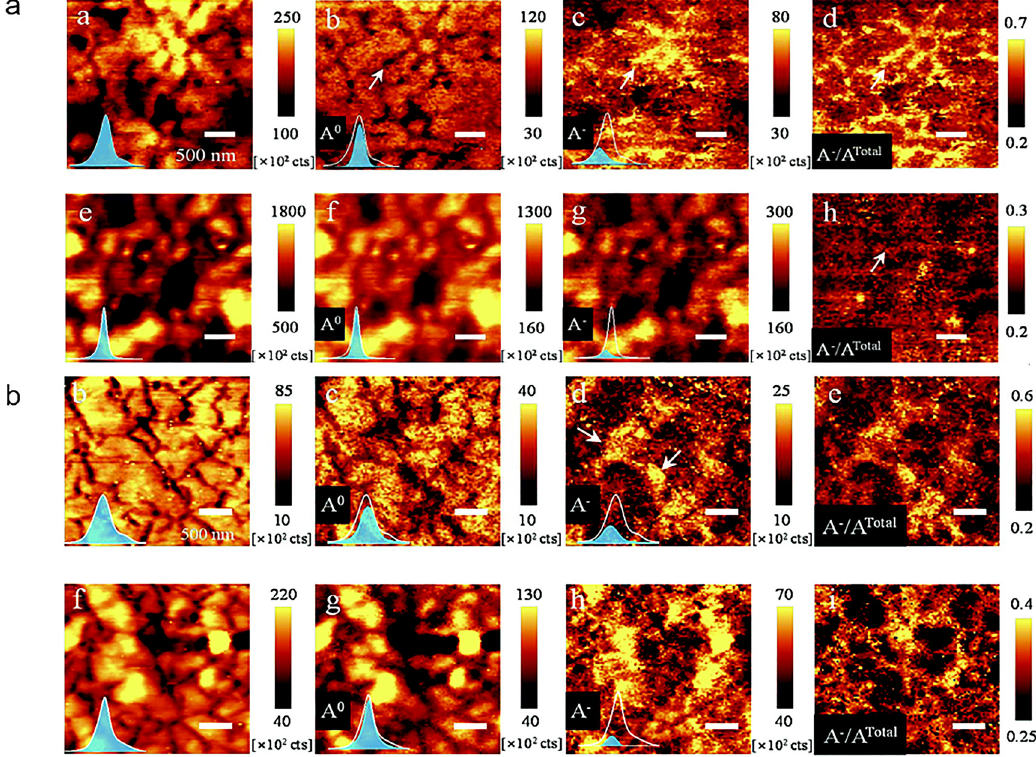
Figure 7: Near-field PL images of 1L-MoS2 by two different chemical treatment. (a) Near-field PL images of total, exciton, trion, and trion/total ratio 1L-MoS2 before (upper panel) and after TFSI-treatment (lower panel). (b) Near-field PL images of total, exciton, trion, and trion/total ratio of 1L-MoS2 before (upper panel) and after TCNQ-treatment (lower panel). Reproduced with permission from ref. [79]. Copyright 2018, Royal Society of